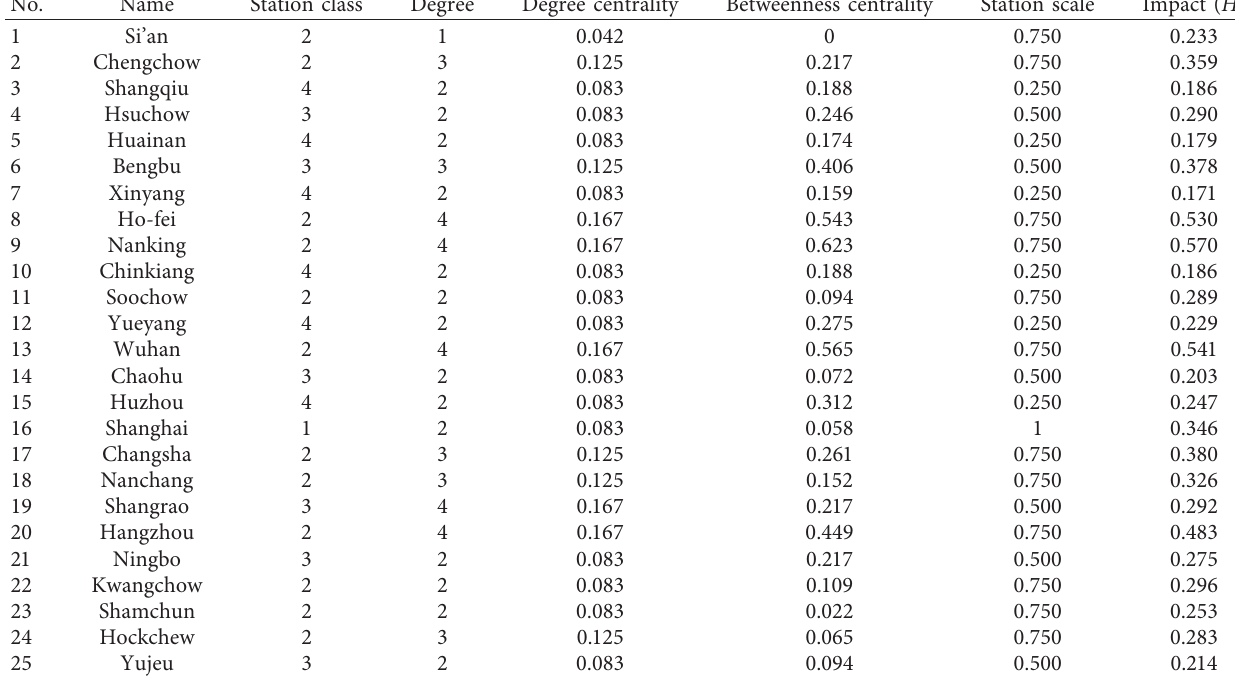
Table 2: Station indexes and